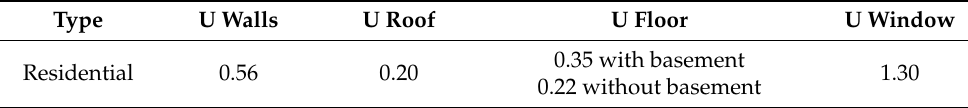
Table 8. Requirements of thermal transmittance (W/m 2 K) in Romania for NZEB [27].